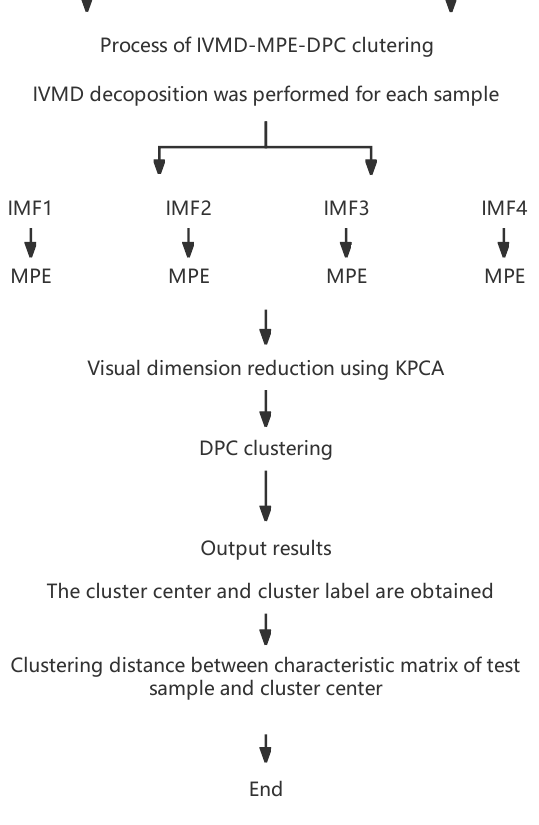
Figure 2. Flowchart of IVMD-DPC.